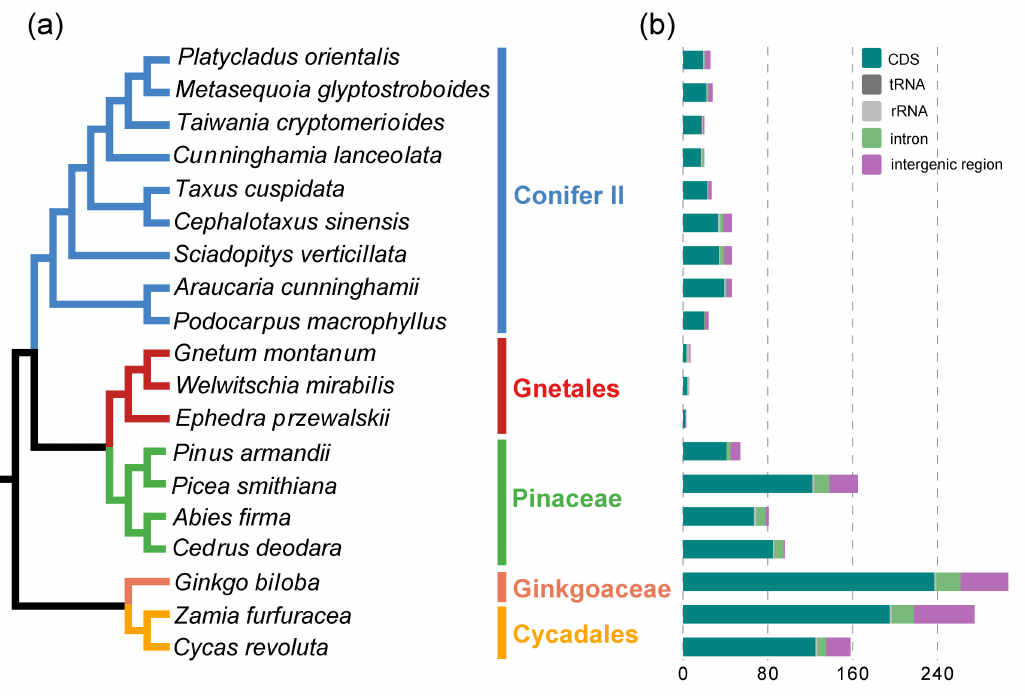
Figure 2. Phylogenetic tree of 19 gymnosperms with associated information of RNA editing sites. ( a ) Cladogram of 19 gymnosperms based on Ran et al. [27,34]. ( b ) Histogram of chloroplast RNA editing site abundance across